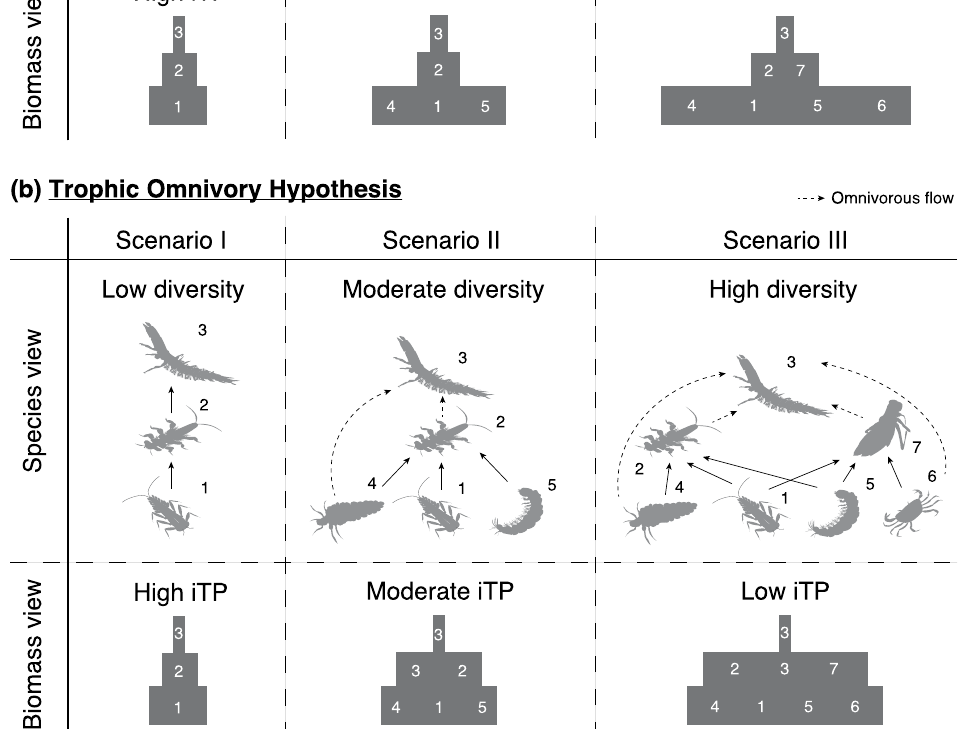
Figure 2. Schematic overview of the present study: ( i ) sample collection from a given area; ( ii ) sorting animal individuals; ( iii ) homogenizing a whole community followed by CSIA-AA; and a simplified illustration of potential hypotheses. ( a ) Variance in edibility hypothesis and/or ( b ) Trophic omnivory hypothesis might explain the negative relationship between biodiversity and the iTP for macroinvertebrates. Numbers are used for species identification in the text. The asterisk and dashed arrow denote inedible (dead-end) species and omnivorous flow, respectively. See the text for